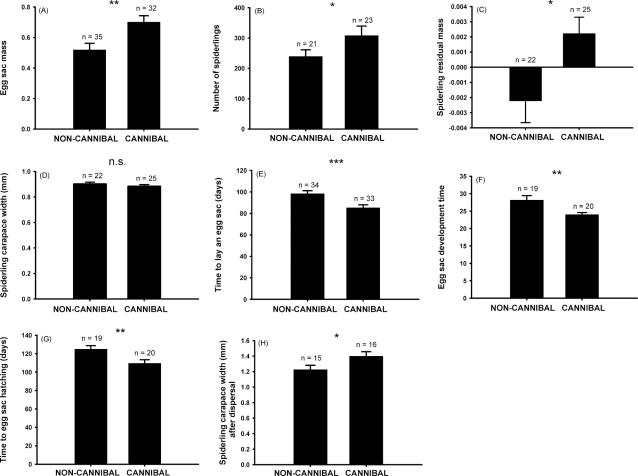
Effects of sexual cannibalism on several reproductive parameters of female Lycosa tarantula.Field Experiment 2 (A–G) and Field Experiment 3 (H). Solid bars and error bars represent means and standard errors, respectively, of (A) egg-sac mass; (B) number of spiderlings that hatched from the egg sac; (C) residual mass of spiderlings at hatching, calculated from a linear regression between the cubic root of weight and carapace width; (D) spiderling body size at hatching (carapace width); (E) time (days) elapsed between female maturation and production of the egg sac; (F) time (days) from production of the egg sac to hatching; (G) total development time (time from female maturation to egg-sac hatching); and (H) body size of spiderlings at the end of the dispersal period, which ranged from 1 to 3 months depending on the mother. Symbols denote the level of statistical significance: n.s., non-significant; *, P<0.05; **, P<0.01; ***, P<0.001.